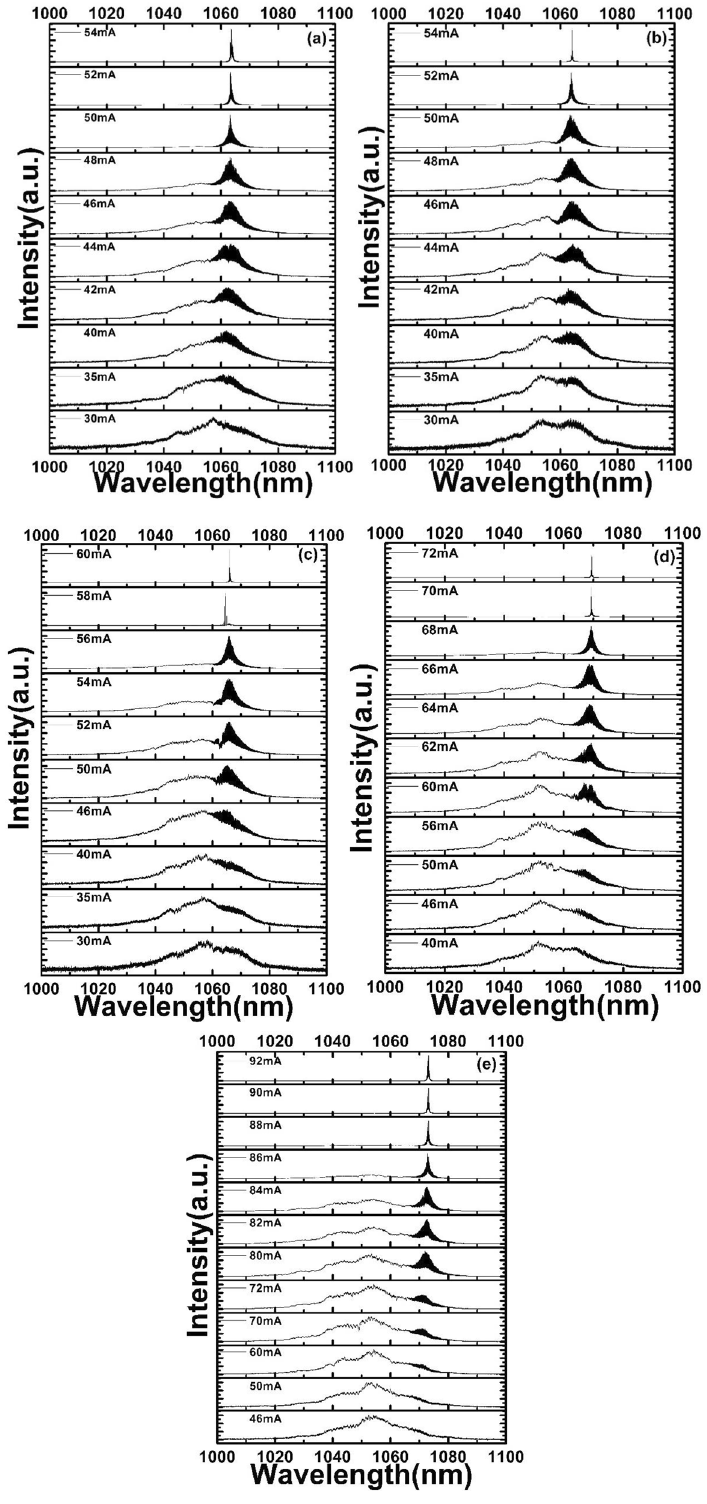
Figure 6. The spectra measured from the InGaAs/GaAs DQW MLL at different V a ( a V a = + 1 V; b V a = 0 V; c